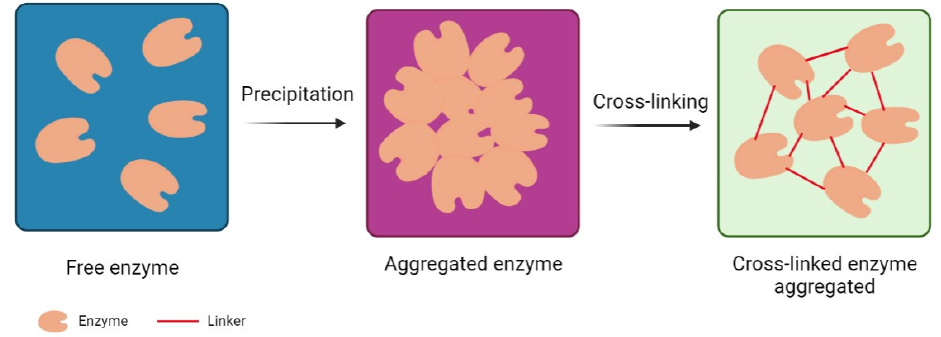
Figure 1. Representation of precipitation and crosslinking steps for the formation of crosslinked enzymatic enzymatic aggregates.